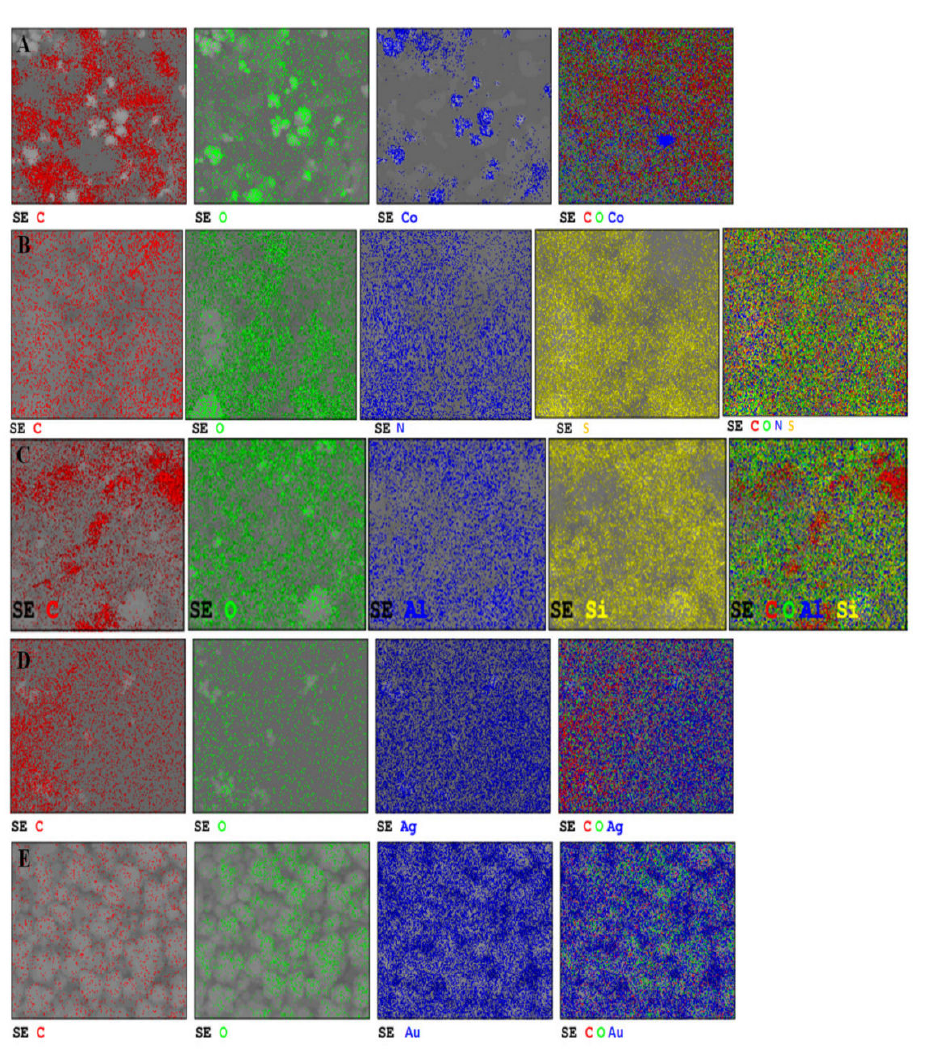
Figure A2. EDX mapping pictures of ( A ) NCOMCPE, ( B ) GORGMCPE, ( C ) ZCNTMCPE, ( D ) SCCMCPE and ( E ) GNMCPE,